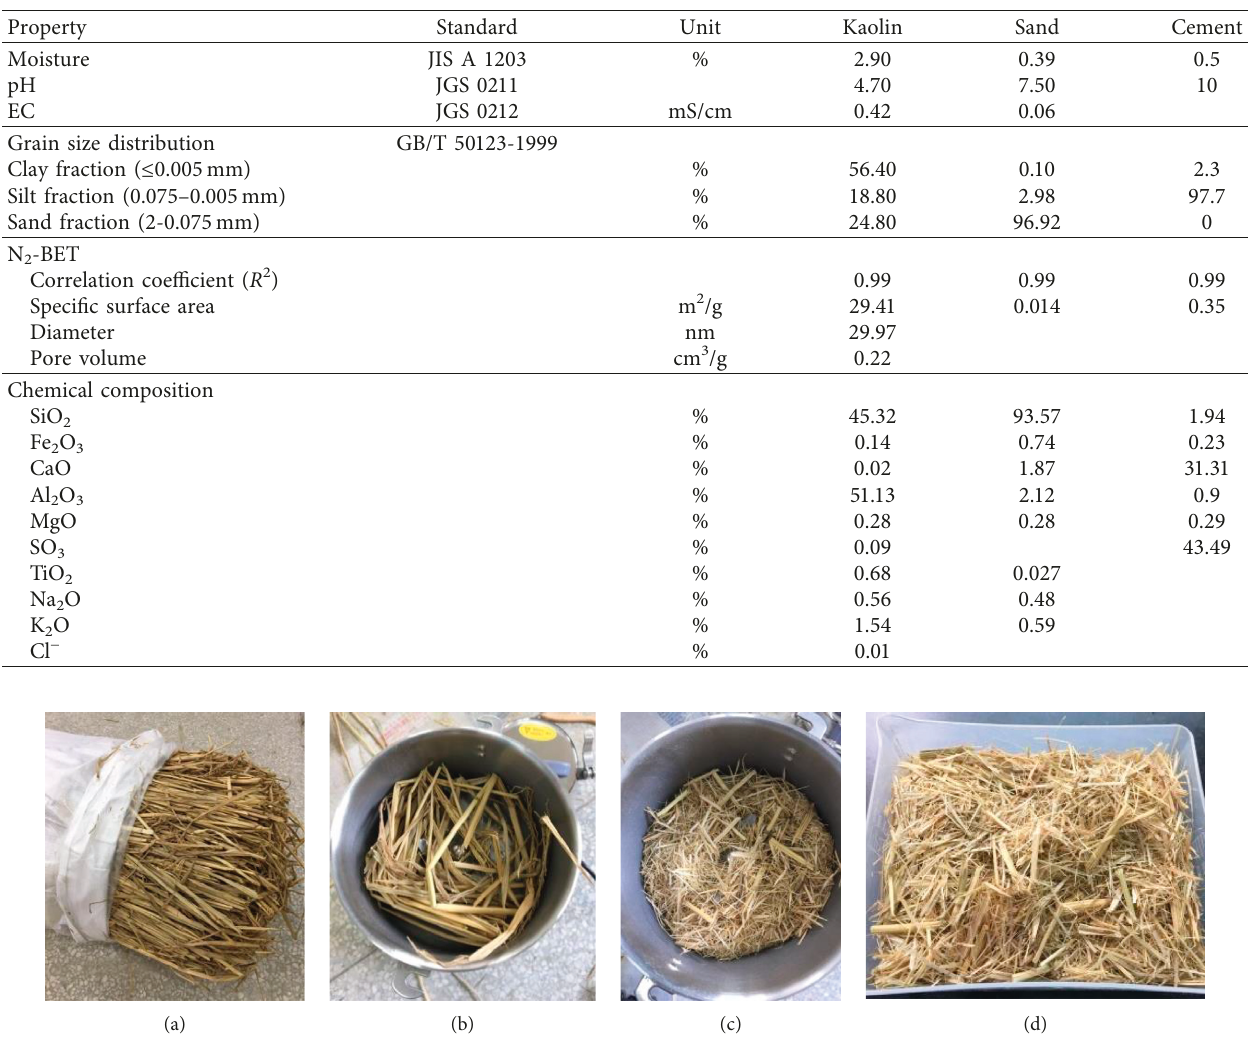
Table 1: Properties of soils and cement.